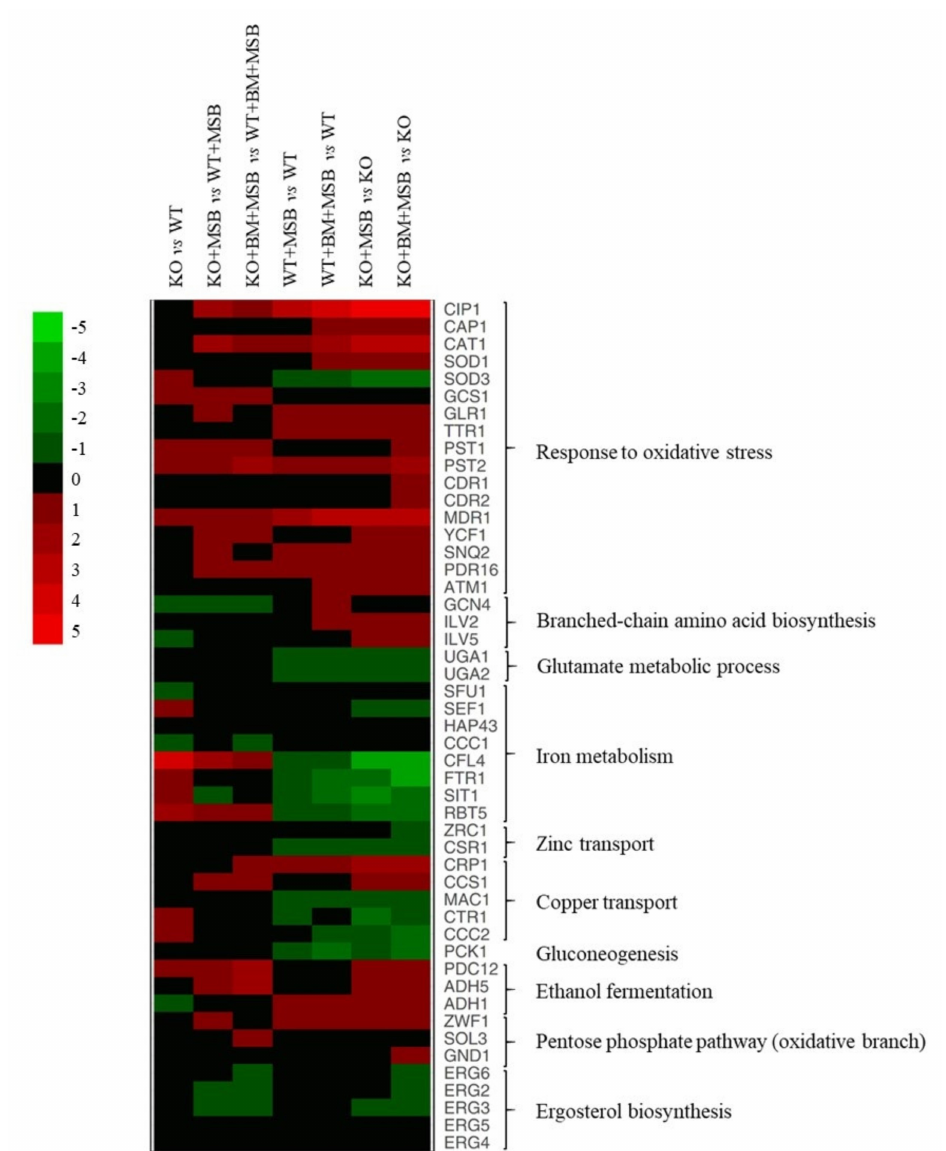
Figure 3. The effects of C. albicans protein phosphatase Z1 ( CaPPZ1) deletion and stress conditions on the expression of selected genes of C. albicans . The heat map demonstrates the expression profiles of representative genes according to the color scale that indicates gene expression changes in log 2 FC units. Supplementary Table S3 summarizes the data that were used for the construction of the heat